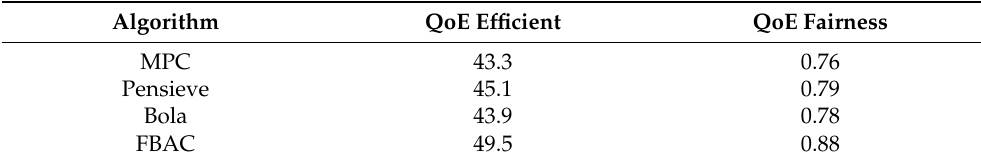
Table 1. Experimental results of under dynamic bandwidth.